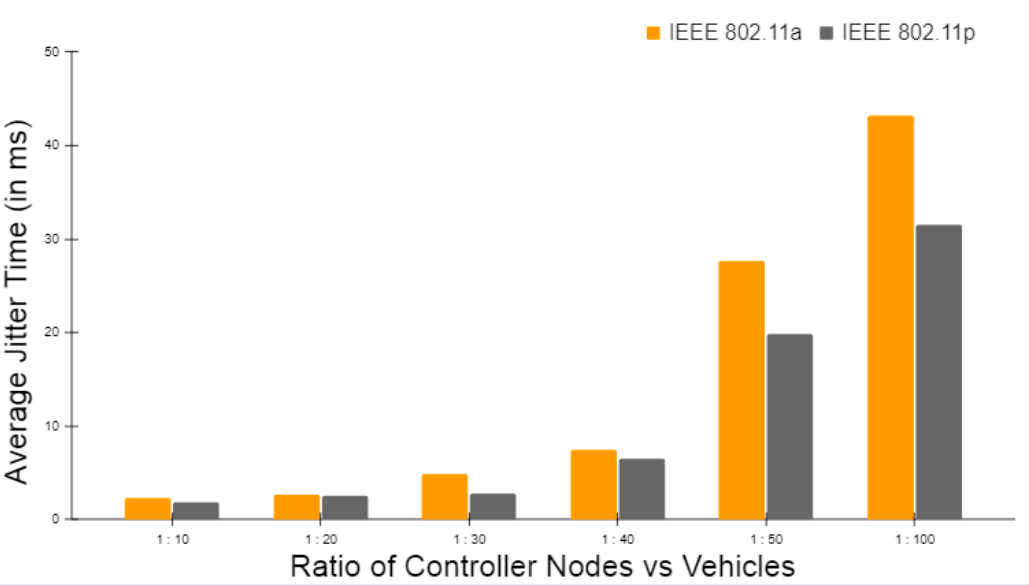
Figure 10. Jitter Time in the proposed framework for IEEE 802.11a vs. IEEE802.11p.